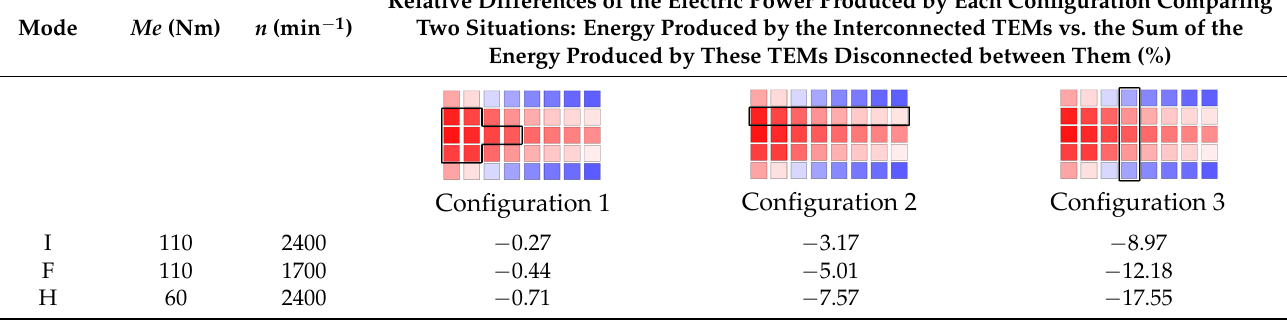
Table 5. Relative differences of the electric energy losses from each configuration presented in Figure 11 and under three of the engine operating modes.